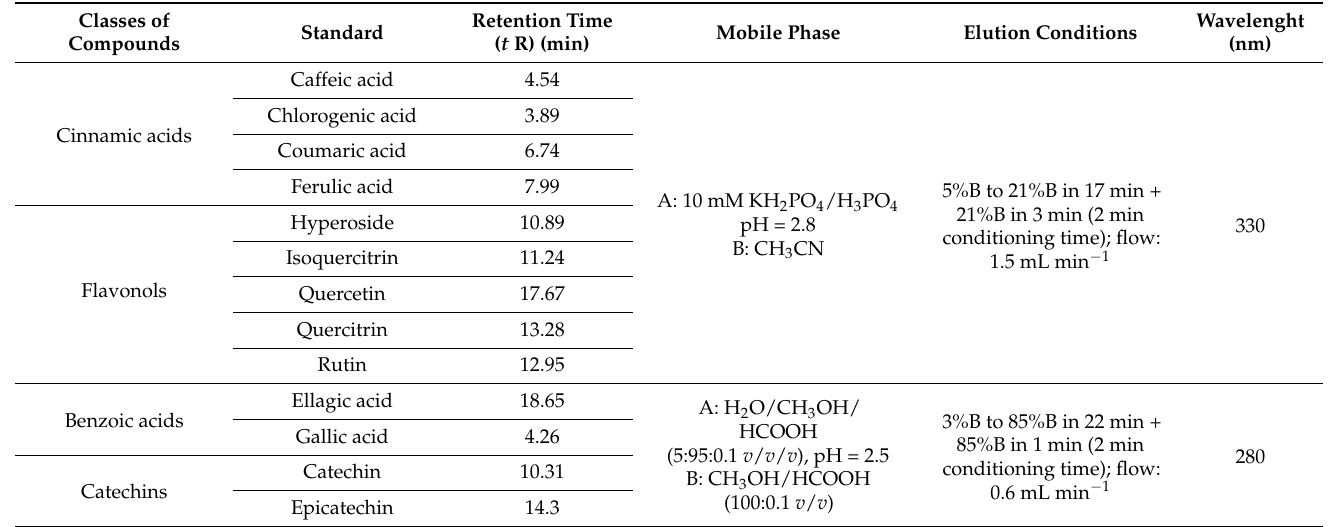
Table 1. Main validation characteristics of the chromatographic methods